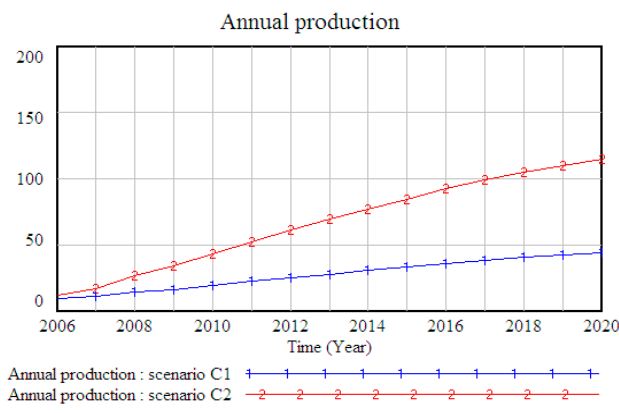
Figure 10. Annual production capability (billion cubic meters).